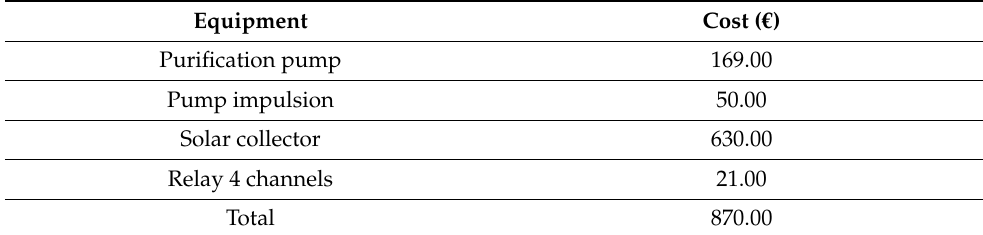
Table 6. Cost of installed equipment scenario 3.